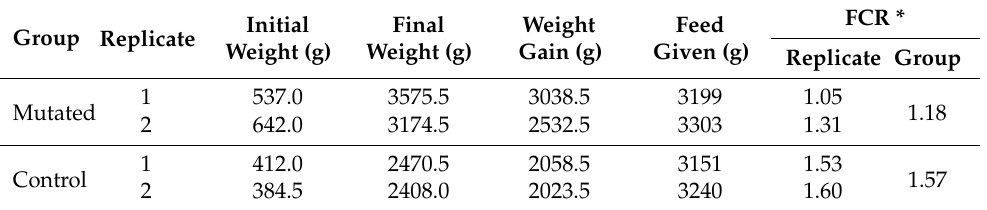
Figure 4. Growth of melanocortin-4 receptor ( mc4r ) mutated Kansas random channel catfish, Ictalurus punctatus , compared with the full-sib control fish. The fish were grown in 60 L glass aquaria in a recirculating system at a density of eight fish per aquarium and two replicates per group. All of the fish were fed ad libitum on a 32% crude protein diet. Means are shown for each sampling time-point, where with different superscript letters indicate significant difference (Two-way month and treatment analysis of variance test with interaction). Table 4. Feed conversion ratio (FCR) of melanocortin-4 receptor ( mc4r ) gene-mutated channel catfish, Ictalurus punctatus , compared with the full-sib control fish (experiment I, electroporation). The fish were reared in 60 L glass aquaria in a recirculating system for nine months. Two replicates of eight fish each were used for the control and mc4r -mutated fish. Each of the initial weight, final weight, and weight gain values presented below are the sum of the values of all of the fish per